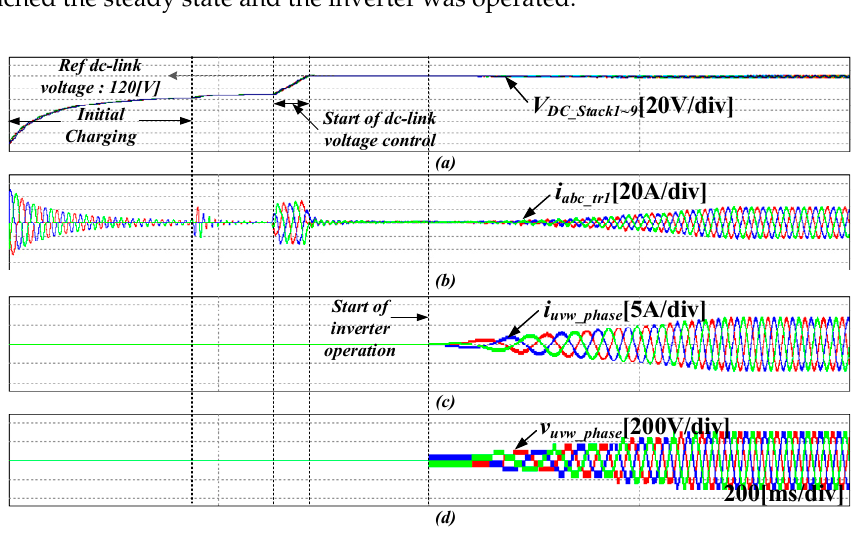
(b) (c) Figure 16. Simulation results of the DC-link neutral-point voltage balance used in 13-level cascaded NPC/H-bridge ( a ) DC-link voltage, ( b ) reference and error voltage between top capacitor and bottom capacitor, ( c ) offset voltage for DC-link voltage balancing. Figure 17 shows the simulation waveform for the failure of the V phase fourth stack of the 13-level NPC/H-bridge inverter. The waveforms are, in order, individual stack reference voltage on U, V, W, output voltage of the first to ninth stack, voltage on U, V, W; line-to-line voltage of UV, VW, WU; phase voltage of U, V, W; and phase current.